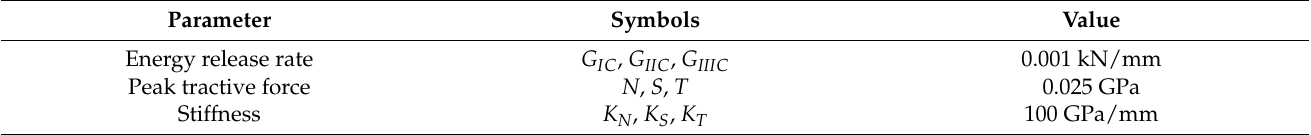
Table 2. “Weak” interlayer strength